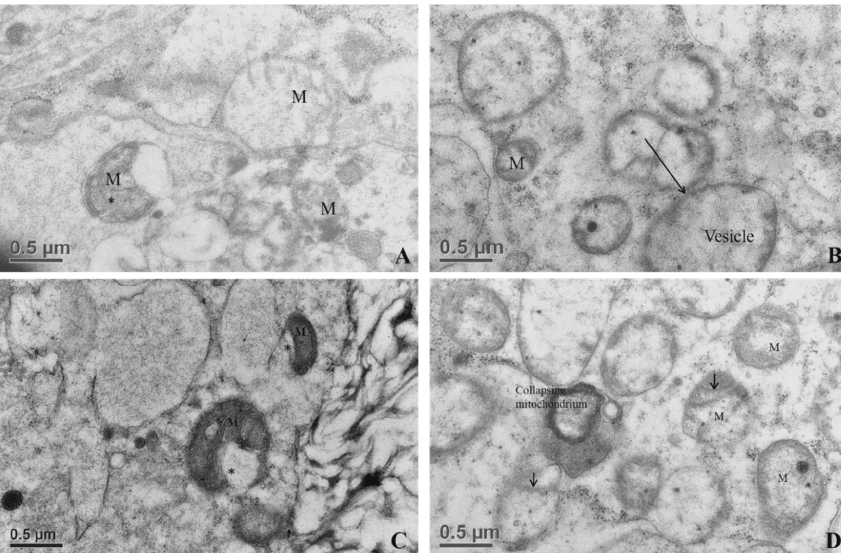
Figure 7. Ultrastructures of the organelles in oocytes of tertiary follicles. ( A ) Ooplasmic aggregate of of organelles in the oocyte. ( B ) Aggregates of vesicles containing electron-dense component in association with mitochondria (mitochondria–vesicle (MV) complexes). ( C ) Electron micrograph of an immature oocyte with hooded mitochondria (*) in the aggregate of organelles. Aggregates of mitochondria associated with vesicles and lipid droplets. In the immature ooplasm, lipid droplets have less electron-dense and granule-like structures. Hooded mitochondrion matrices possessing well-developed cristae (arrow). ( D ) Collapsing mitochondrion was observed in the tertiary follicle oocyte. M,